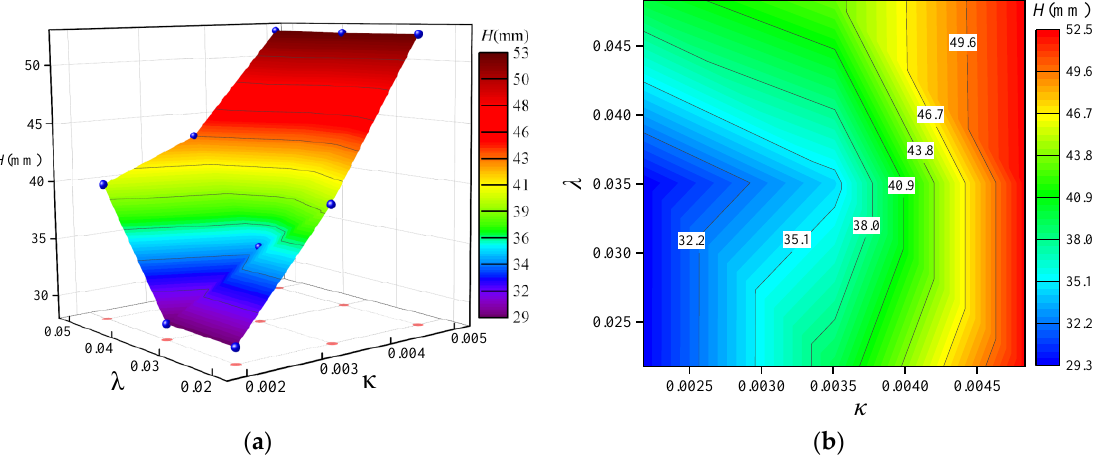
Figure 9. Effect of λ and κ on the ground settlement: ( a ) 3D view; ( b ) 2D planar view.